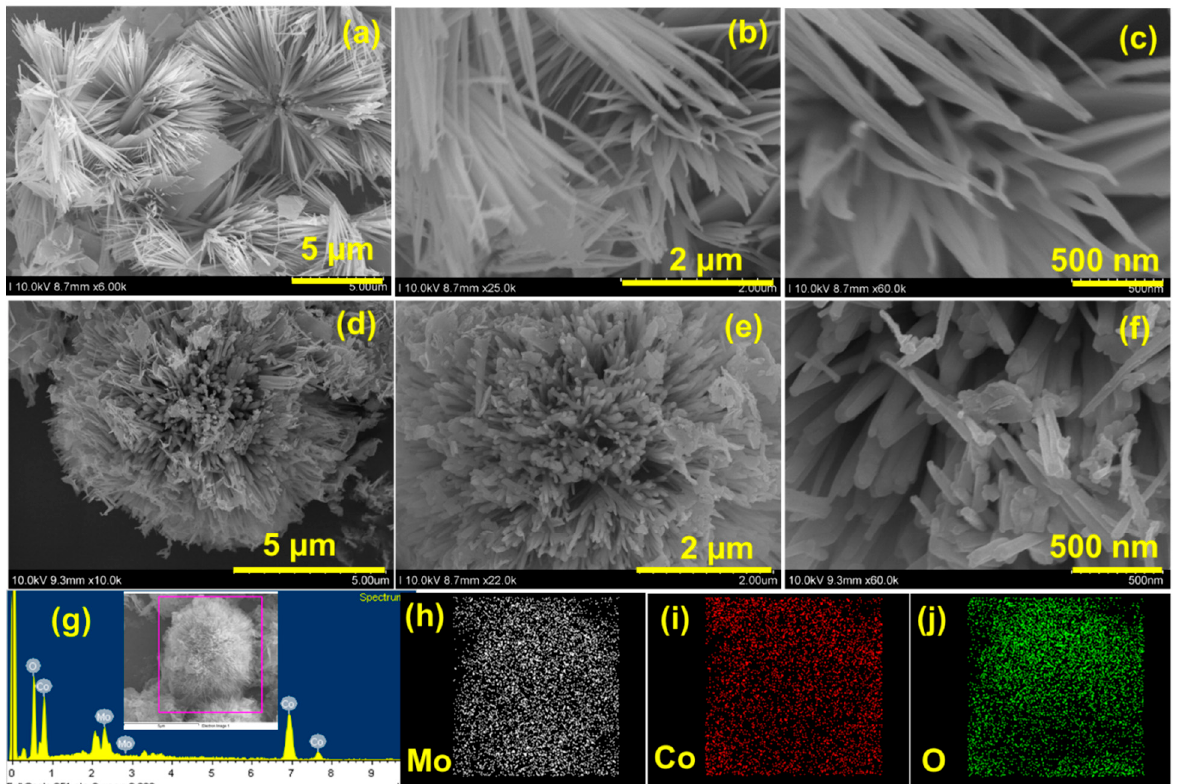
Figure 3. ( a – f ) FE-SEM images of Co 3 O 4 @Mo-Co 3 O 4 needle-like nanosheet heterostructure at different magnifications, ( g ) EDS spectra: inset mapping image of Co 3 O 4 @Mo-Co 3 O 4 , ( h ) elemental map of Mo, ( i ) elemental map of Co, and ( j ) elemental map of O.